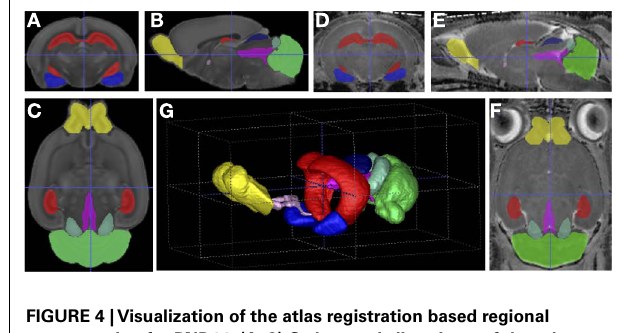
FIGURE 4 |Visualization of the atlas registration based regional segmentation for PND14: (A–C) Orthogonal slice views of the atlas; (D–F) views on an example dataset; (G) 3D-rendering of example segmentation. Red: hippocampus, green: cerebellum, blue: amygdala, yellow: olfactory